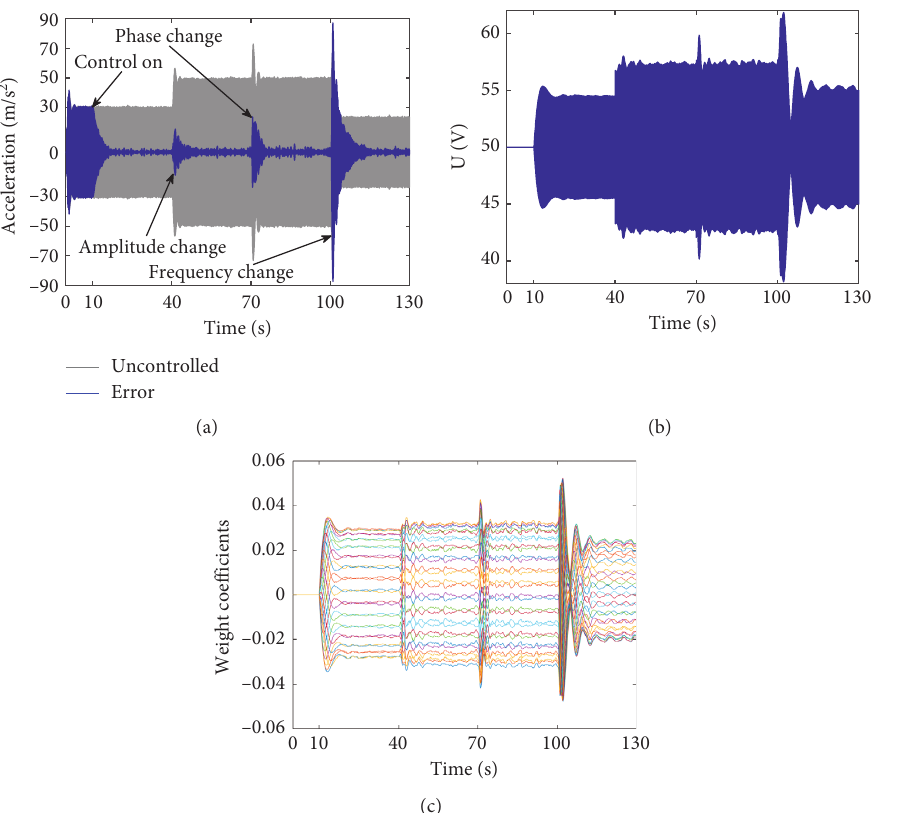
Figure 13: Adaptive control experimental results of the DVSFxLMS controller: (a) acceleration response at point A; (b) output voltage; (c) adaptive filter weight coefficient iteration